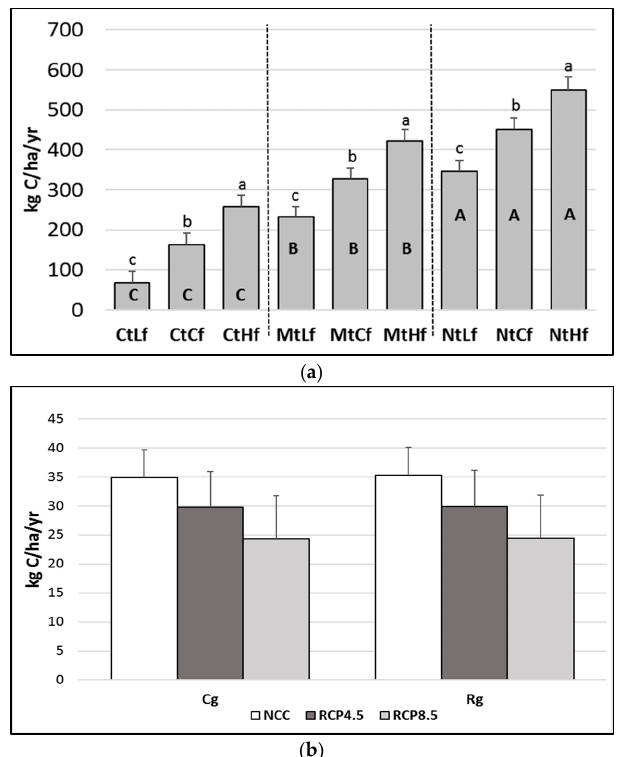
Figure 3. DNDC-modeled mean annual soil organic carbon (SOC) dynamics (0–50cm) ( ±se ) from